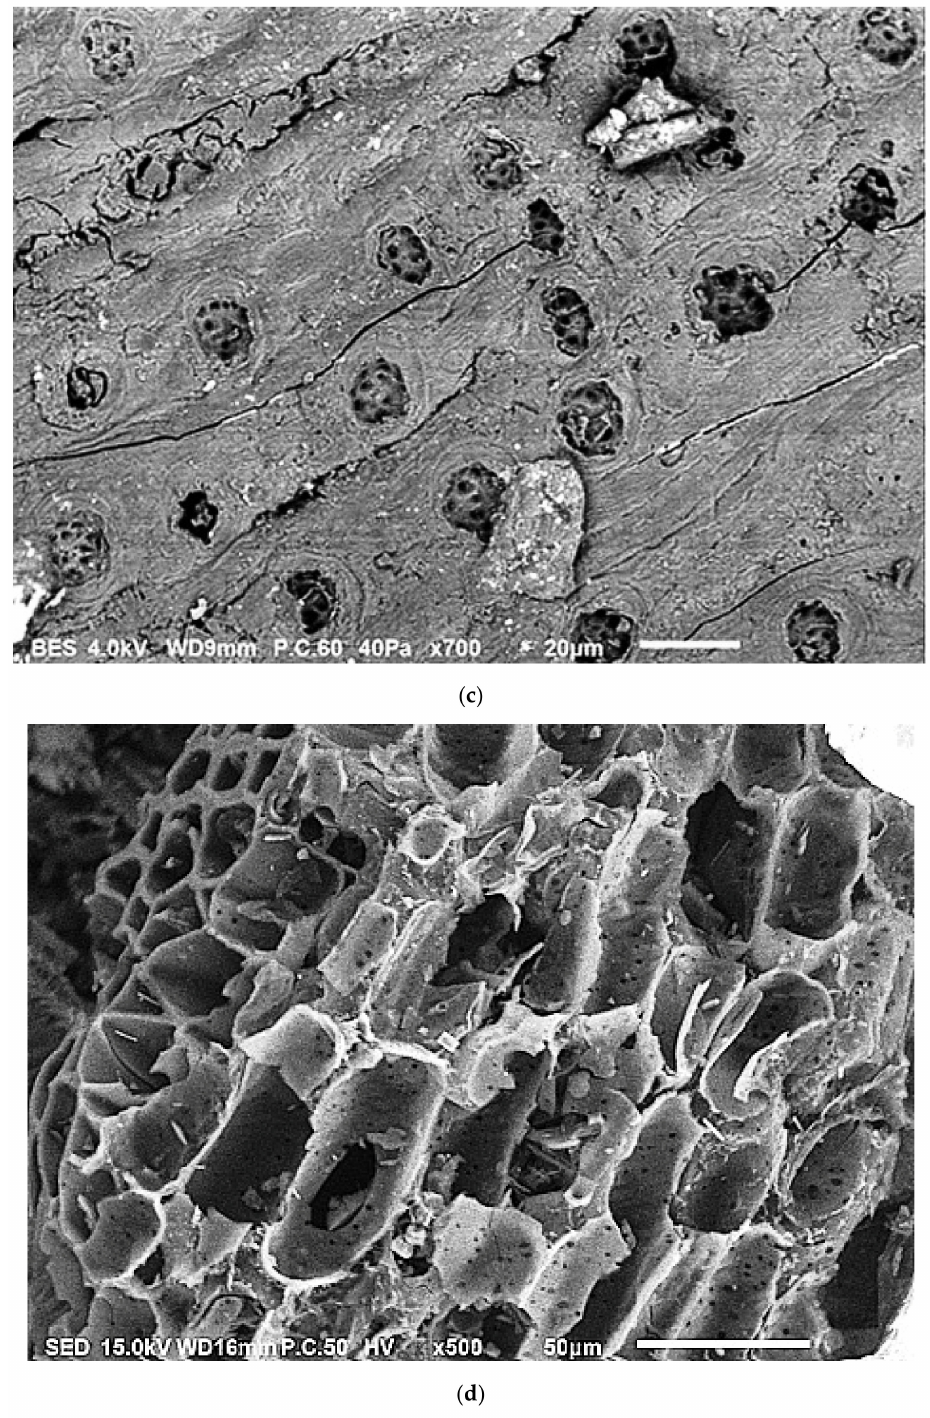
Figure 1. SEM images indicating carbon before activation ( a ), and after activation with H 3 PO 4 ( b ), ( c ), and ( d